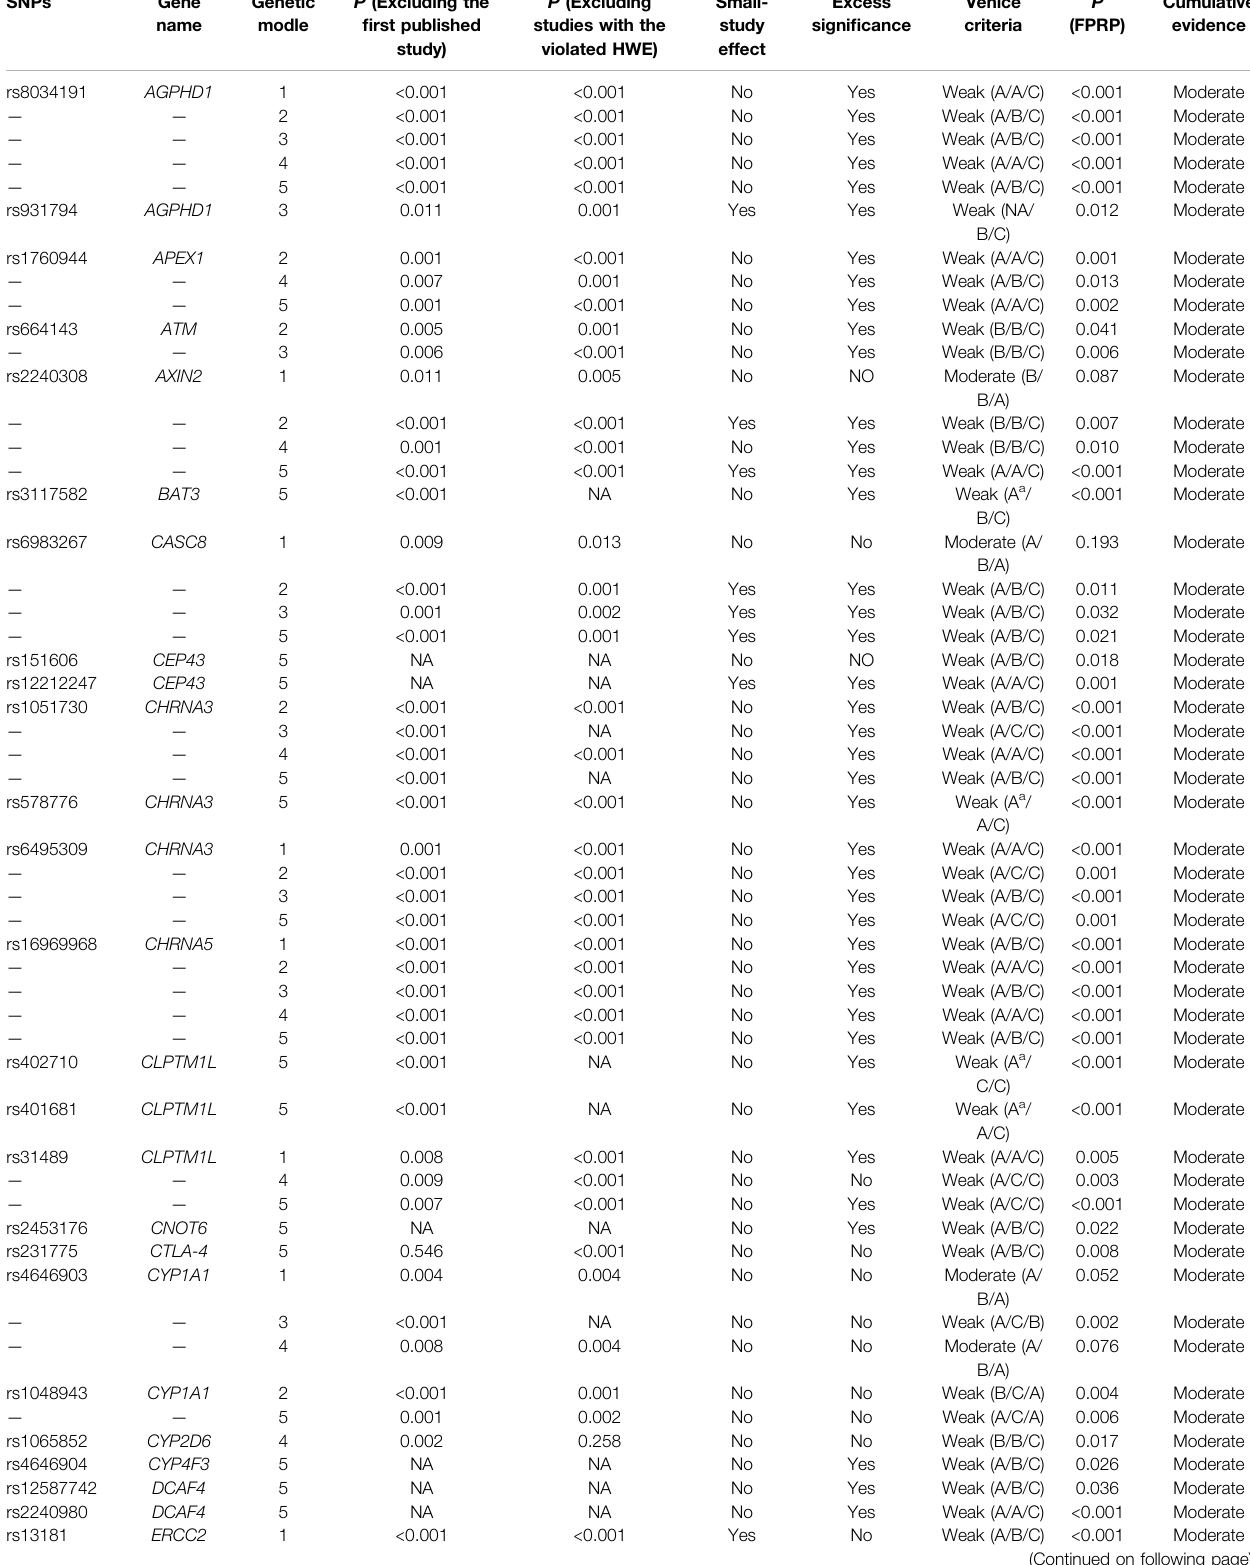
TABLE 4 | Cumulative evidence details of SNPs with the moderate cumulative evidence based on the Venice criteria and